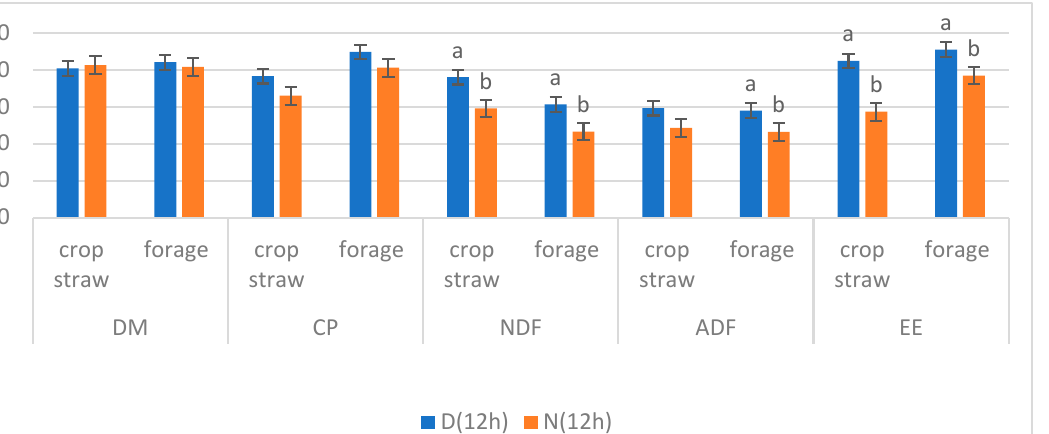
night, whereas the NDF of roughage grass was 14.68% higher.